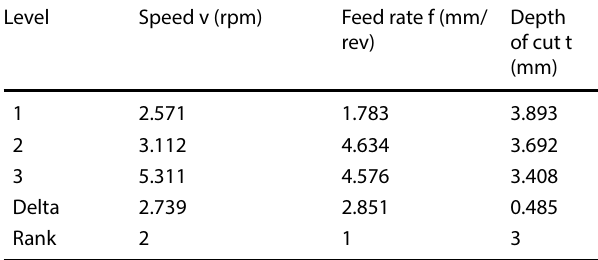
Table 3 Response values for S/N ratio (smaller is better) Level